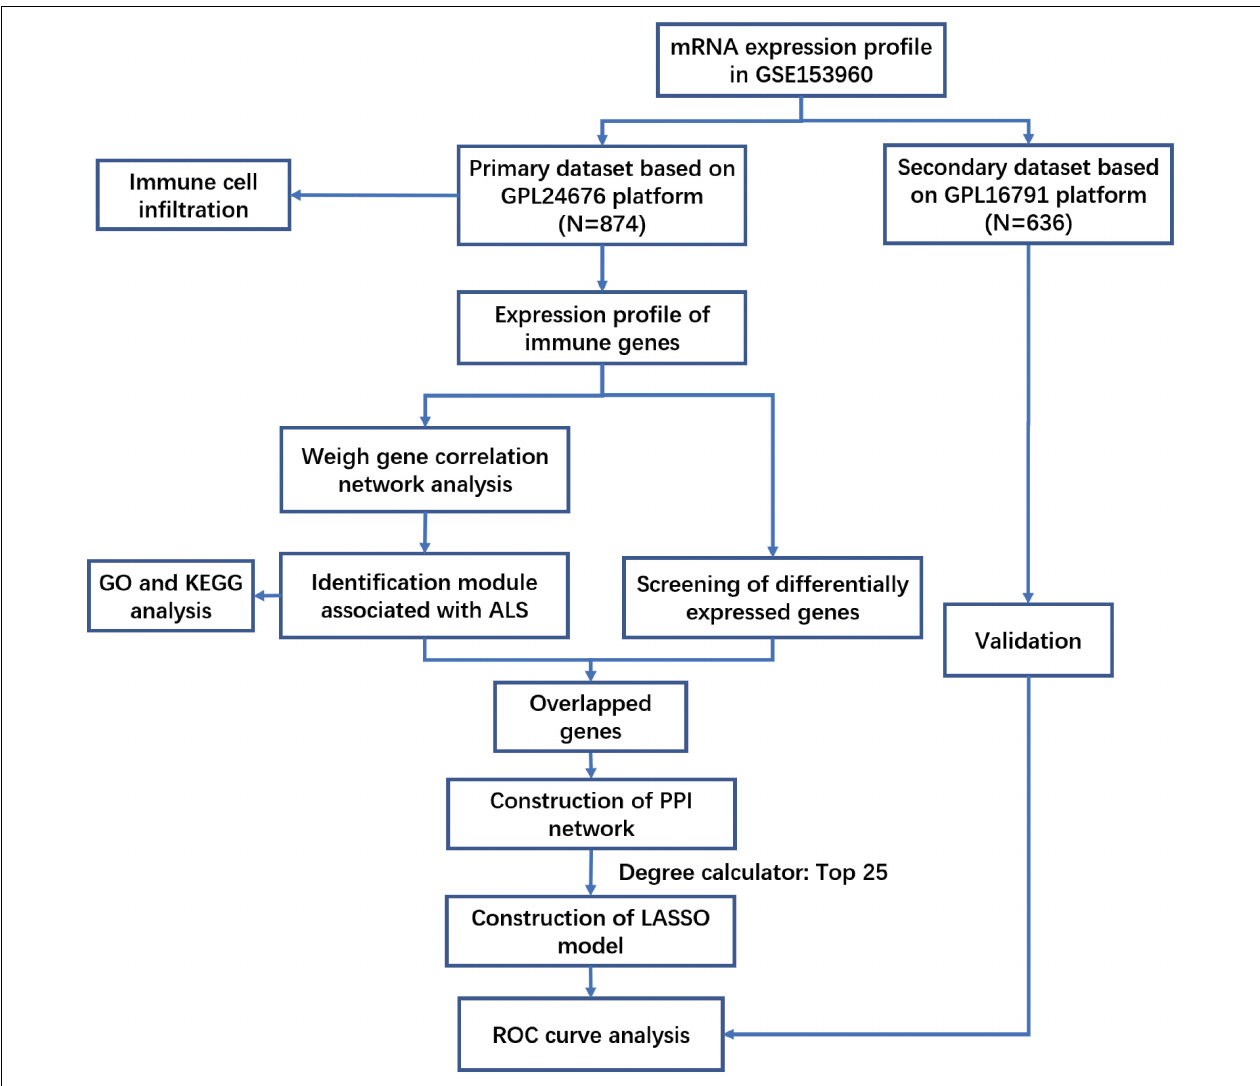
FIGURE 1 | The workflow of this study.